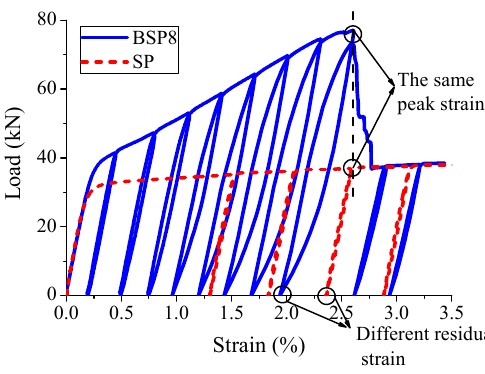
Figure 12. Comparison of the test values between BSP and SP under cyclic tensile